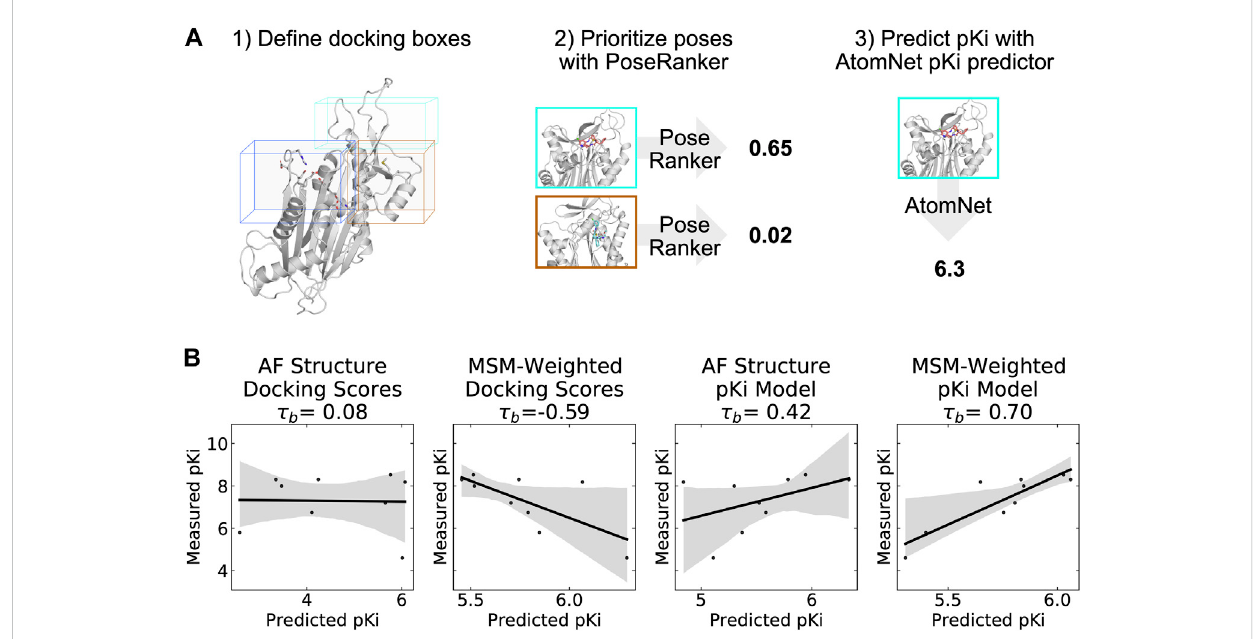
FIGURE 5 A neural network trained to predict pKi accurately ranks allosteric compounds by potency when applied to structures from a PPM1D ensemble. (A) Schematic highlighting the procedure that was used for selecting a single pose for each PPM1D cluster center in the MSM. For each MSM cluster center, we de fi ned multiple docking boxes based on the active site, residues involved in photolabeling experiments, and P2Rank pockets at the fl ap and hinge. After performing docking, we selected a best pose per MSM state using the PoseRanker neural network. Finally, we fed this best docked pose to the AtomNetpKipredictor. (B) MSM-weightingofthepKipredictionsfromtheAtomNetpKipredictoroutperformsdocking-basedmethodsaswellasasingle pKi prediction based on the AlphaFold-predicted structure. For each scatter plot, we show the line of best fi t in black as well as the 95% con fi dence interval based on bootstrapping in translucent grey bands. We report the Kendall rank correlation coef fi cient, a statistic that measures the ordinal association between the predited pKi and the measured pKi and whose maximum value is